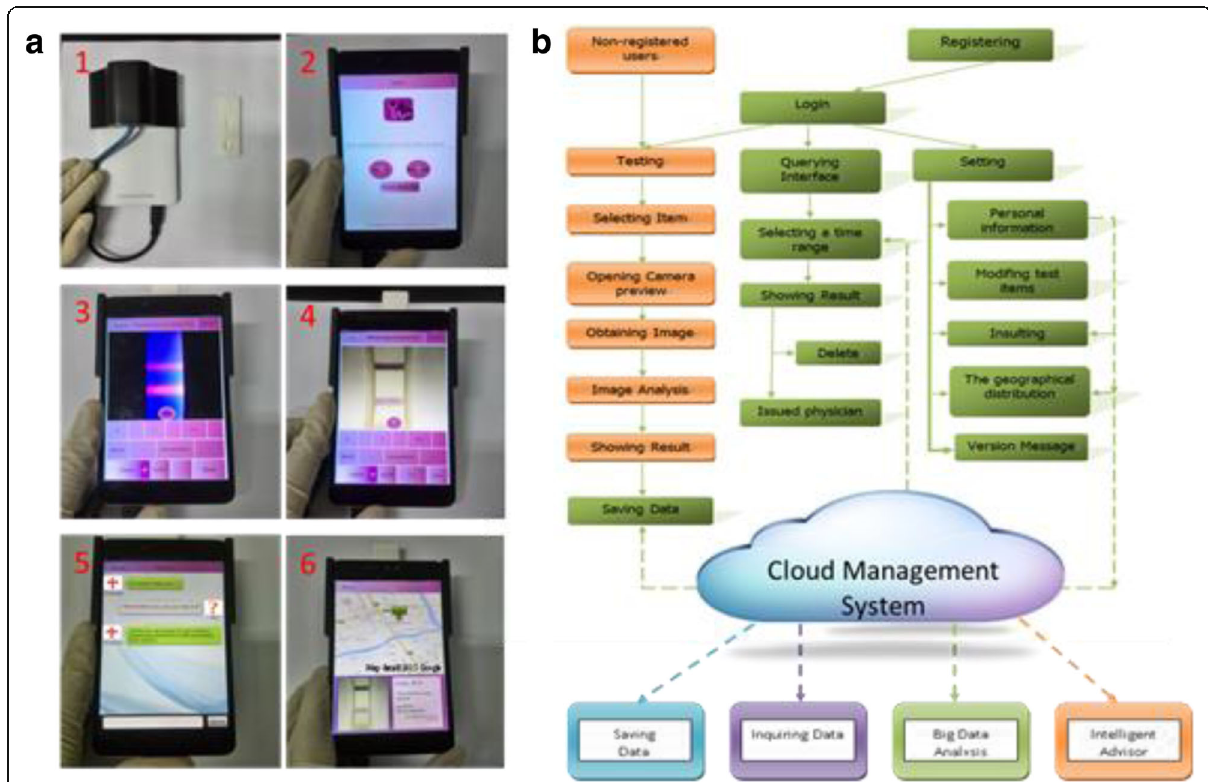
Fig. 3 a 1 Back view of testing equipment and the strip shell physical figure. 2 The main menu of the software. 3 The fluorescent strip test displaying (CEA). 4 The color strip test displaying (colloidal strip for testing HCG). 5 The robot service through chat. 6 The location distribution of the test result in Google map (Map data: Google, DigitalGlobe). b Flow diagram of the device